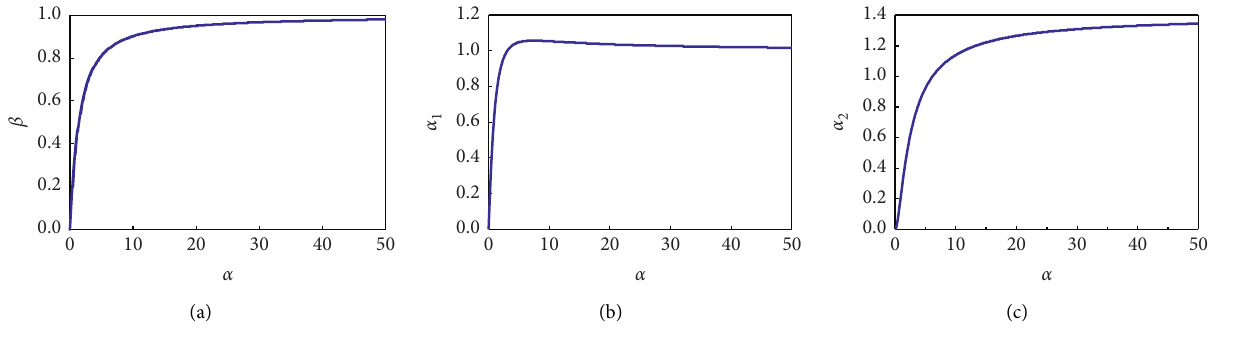
Figure 2: Variations of β , α